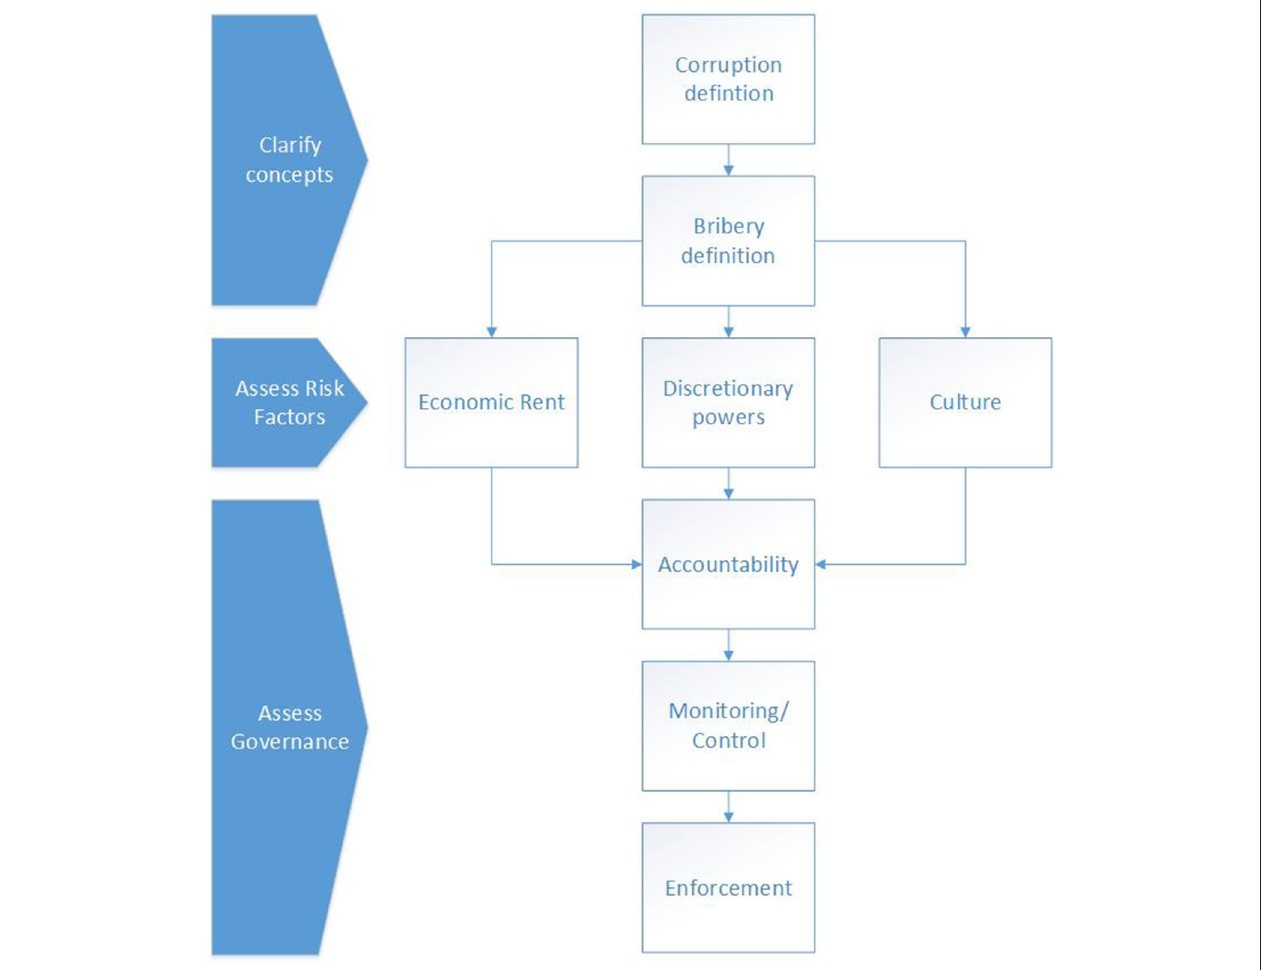
FIGURE 1 | Theoretical framework for bribery and ABC. Adapted from Philippou